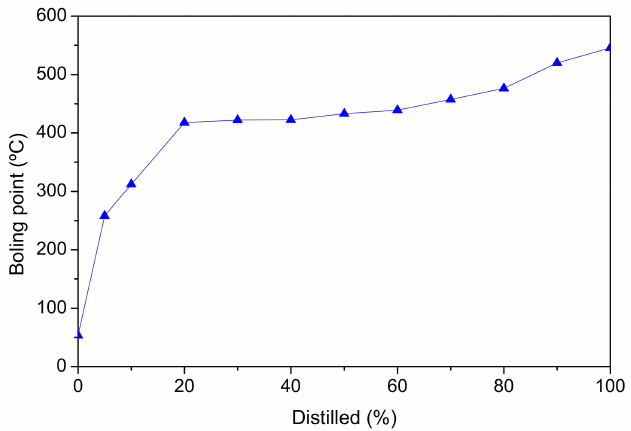
Figure 7. Simulated distillation of biocrude obtained at 320 ◦ C, 10 min and 10 wt% of biomass ( (cid:78)